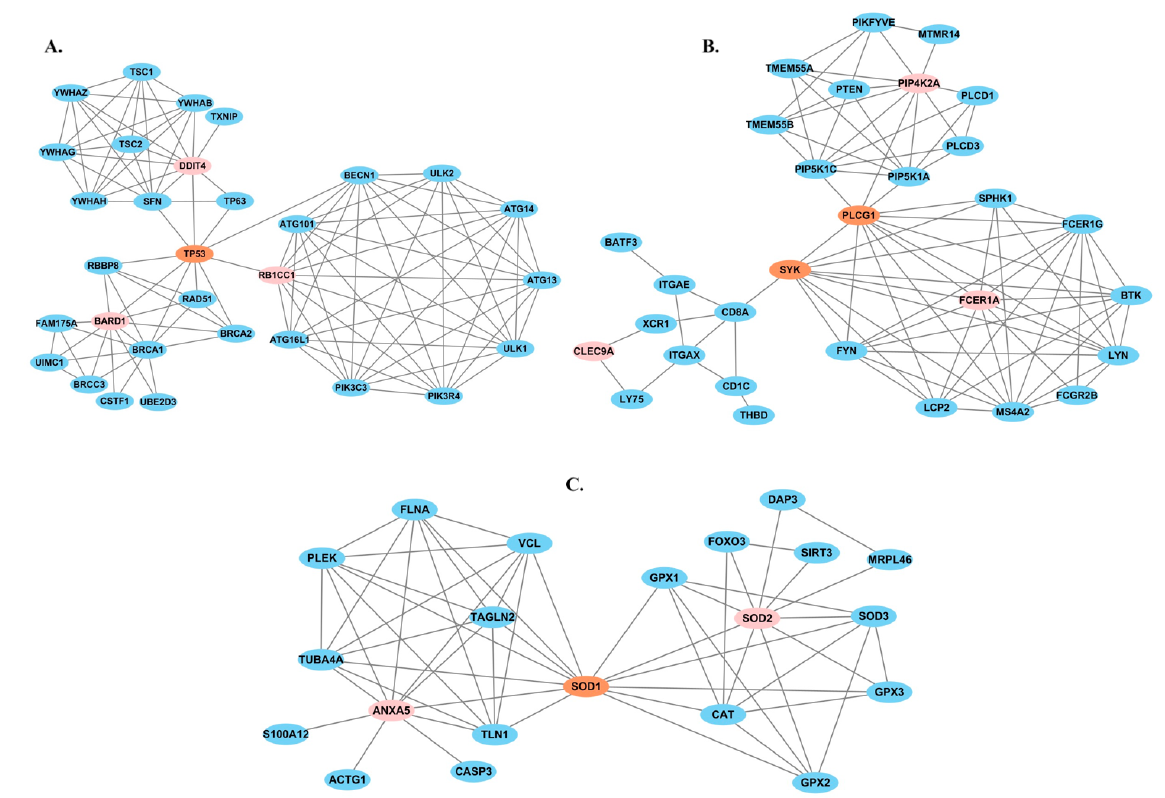
Figure 3. The PPI networks of response predictive gene markers. ( A ) TP53 connected the PPI networks of BARD1 , RB1CC1 , and DDIT4 . ( B ) PLCG1 and SYK connected the PPI networks of FCER1A , PIP4k2A , and CLEC9A . ( C ) SOD1 connected the PPI networks of SOD2 and ANXA5